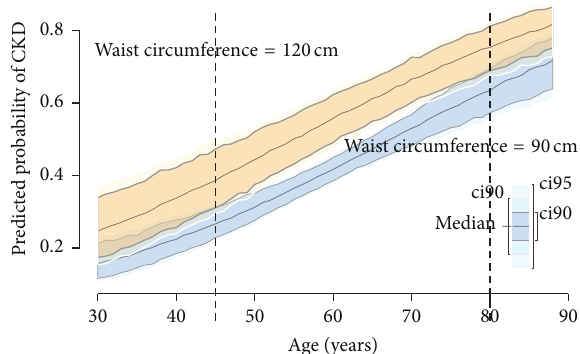
Figure 2: Effect of waist circumference on chronic kidney disease risk by age. We compared the CKD risk for those having WC = 120 cm with those having WC = 90cm. The 𝑥 -axis represents the age of the T2D patients, and the 𝑦 -axis represents the estimated probability of CKD risk. The solid lines represent the estimated probabilities, the dashed line corresponds to age = 45 and age = 80, respectively, and the shaded areas represent the corresponding con- fidence intervals. WC: waist circumference; CKD: chronic kidney disease; T2D: type 2